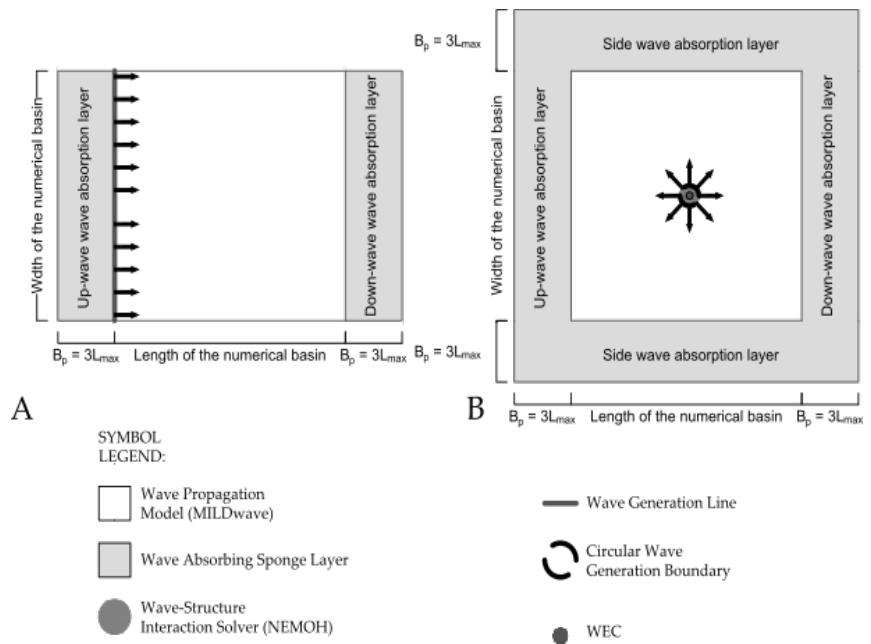
Figure 3. Set-up of the different numerical wave basins used in MILDwave. ( A ) Incident Wave Field numerical wave basin. ( B ) Perturbed wave field numerical wave basin with a single WEC. The coupling region corresponds to the wave-structure interaction solver NEMOH domain defined in the perturbed wave field numerical wave